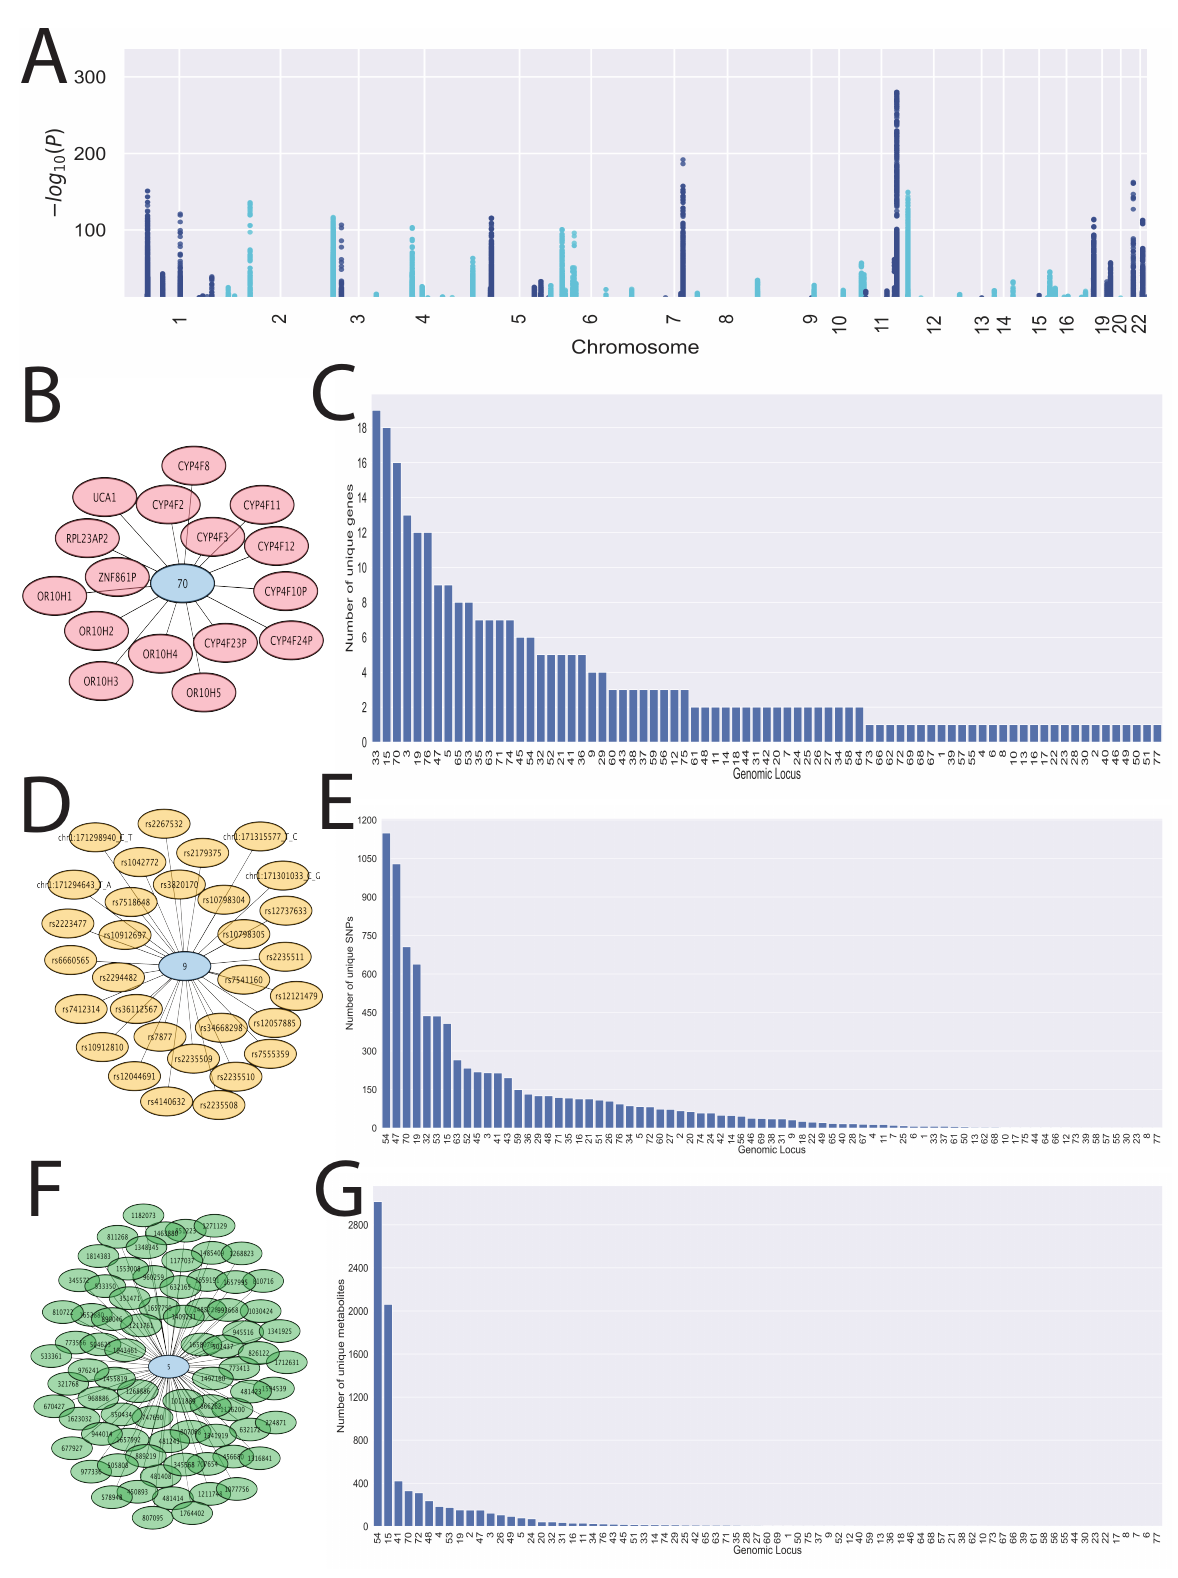
Figure 2. The targeted SNP association study linked SNPs in drug-related genes, like enzymes and transporters, to the circulating levels of small, polar, bioactive molecules. ( A ) Manhattan plot